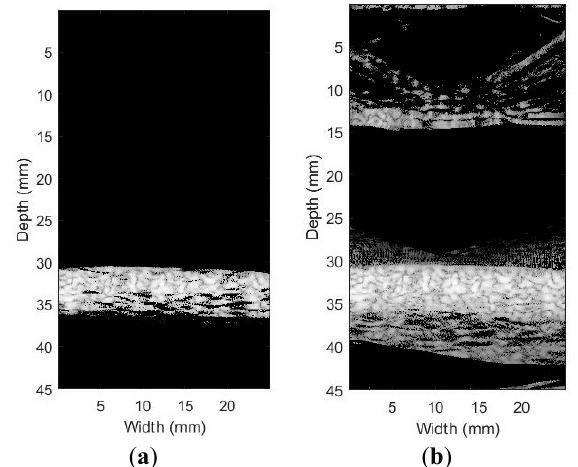
Figure 11. The image result of bubble region detection under different thresholds: ( a ) Higher threshold and ( b ) lower threshold.